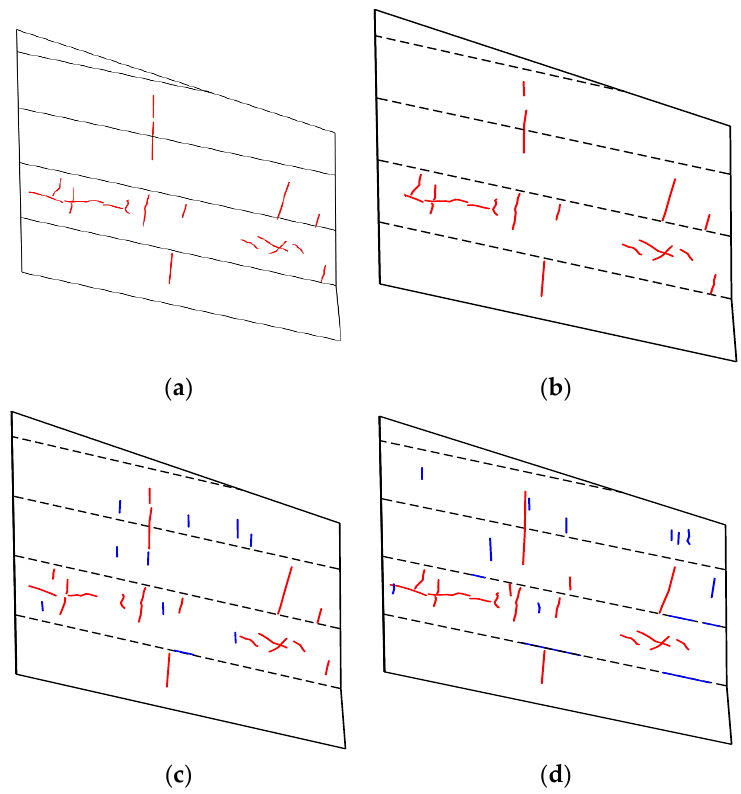
Figure 14. The cracks identified by the proposed method for three cases. ( a ) Crack map by visual inspection; ( b ) Original image; ( c ) Case 1; (d) Case 2.